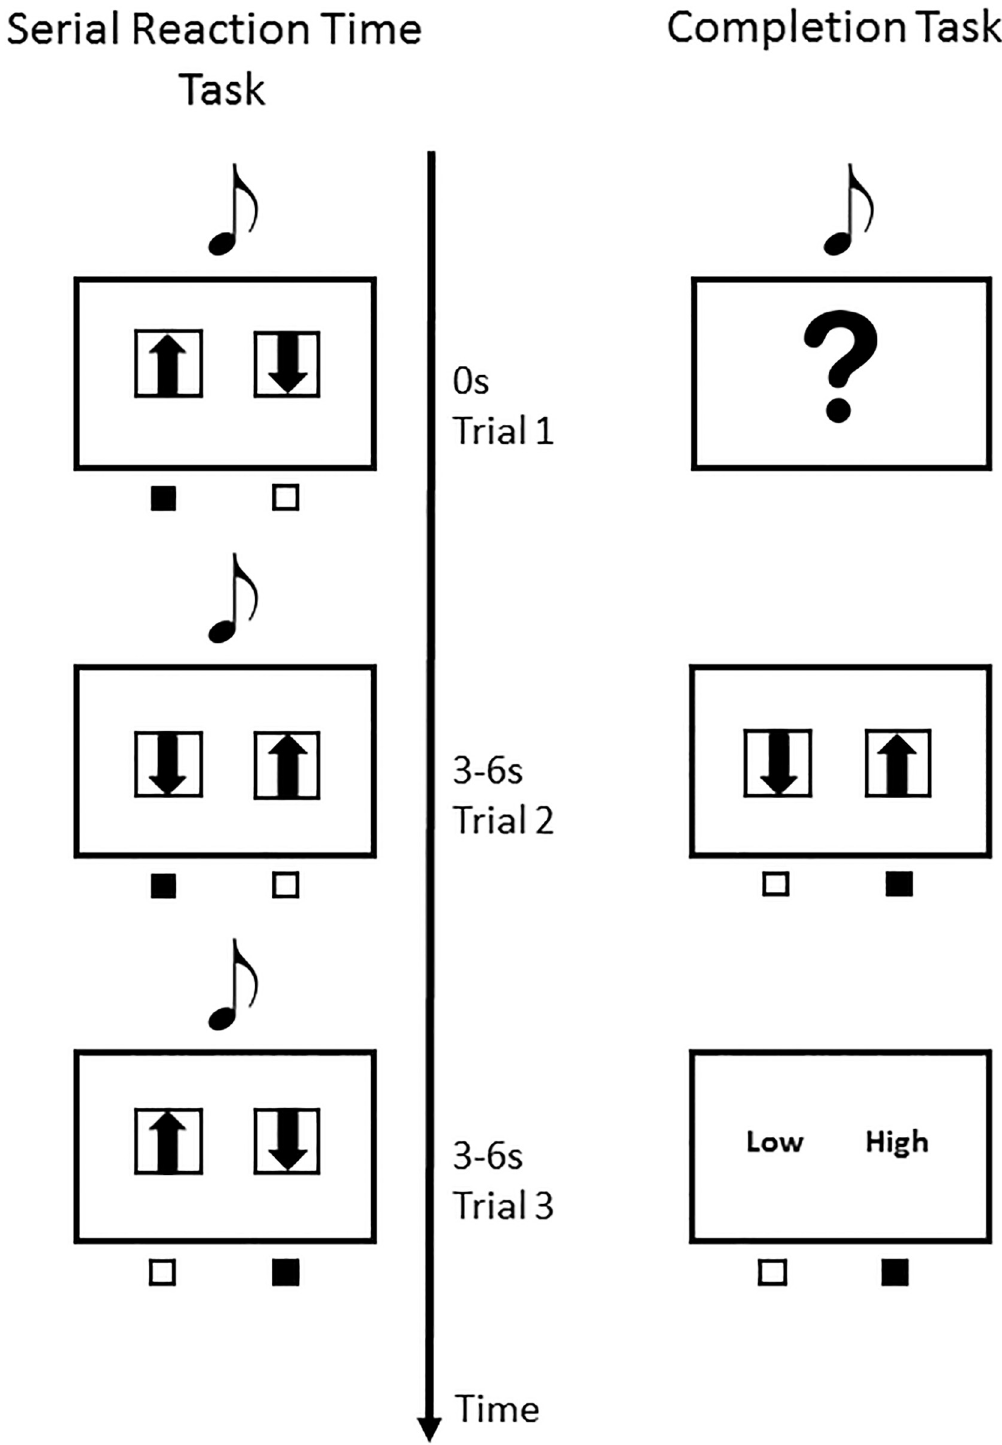
Fig 1. Example of the acoustic SRT task (left) and completion task (right). In both tasks, a sinusoidal tone was presented and responses were given via button press. The locations of the arrows, indicating the two response options (high vs. low), were assigned to corresponding buttons. In each trial of the SRT task, a remapping of the stimulus to the response was implemented to prevent motor learning. In the completion task, in contrast, after each tone presentation participants were instructed to predict the next tone as well as to rate their confidence by pressing the corresponding